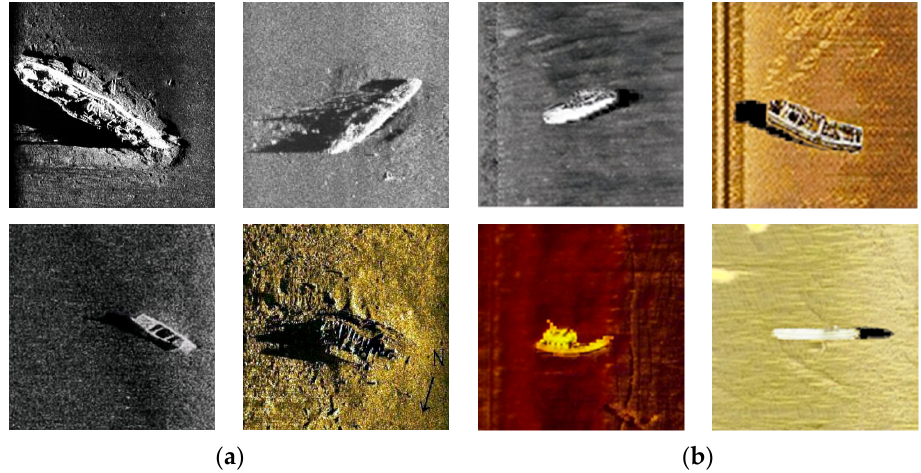
Figure 20. Augmented SSS images. ( a ) SSS images augmented by the proposed method. ( b ) SSS images augmented adapted from Huang et al. [52] with permission from IEEE CCC, 2023.